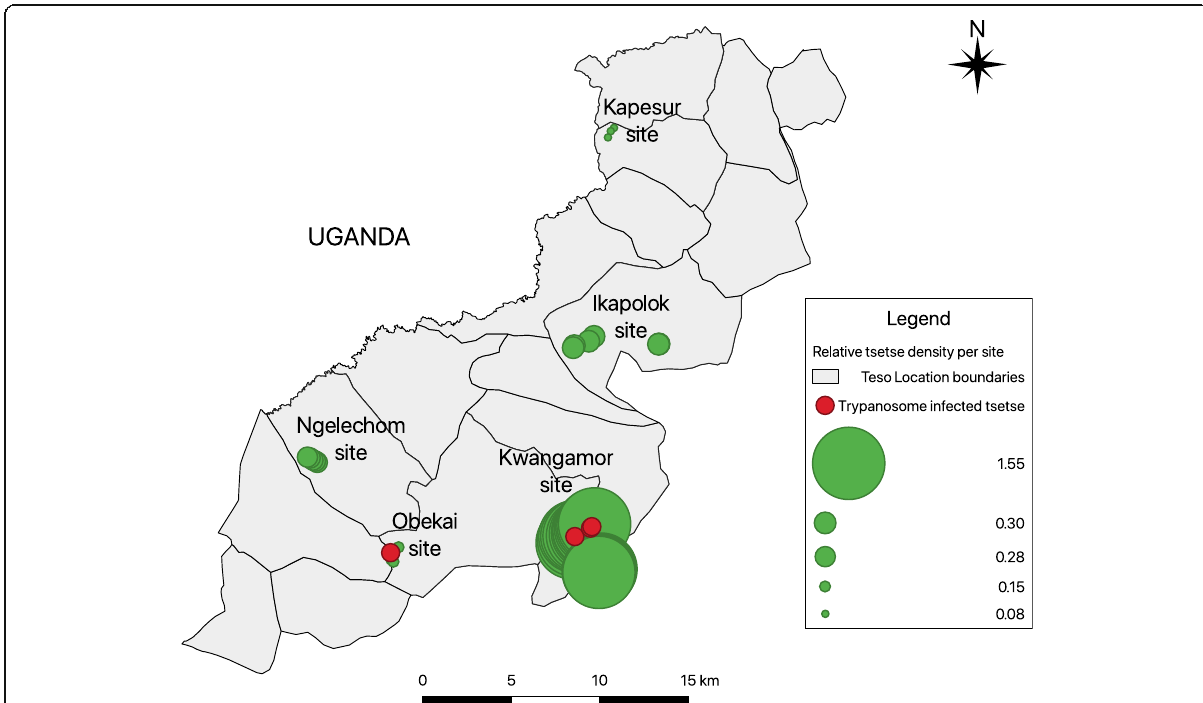
Fig. 2 Map showing the apparent tsetse density and traps with infected tsetse fly. Colour codes: red shows at least one infected tsetse fly and green shows zero infected tsetse fly. Relative size of the circle shows differences in tsetse density at each